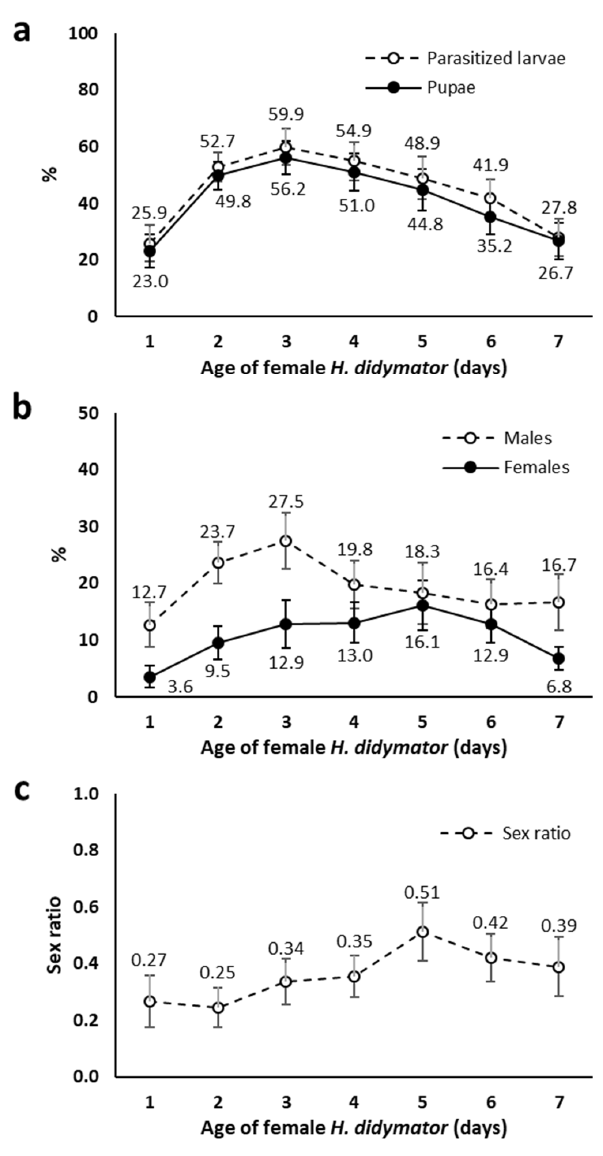
Figure 2. Efficiency of Hyposoter didymator females over the course of their lifespan when parasitizing daily since emergence over seven consecutive days. ( a ) Parasitized larvae and parasitoid pupae in relation to the number of larvae offered to the parasitoid; ( b ) male and female adult offspring in relation to the number of larvae offered to the parasitoid; ( c ) sex ratio of the offspring (number of females/number of adults).